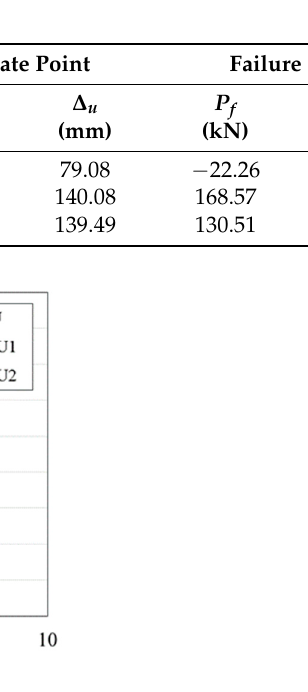
Figure 8. Comparison of the stiffness degradation of specimens. Table 6. The stiffnesses of